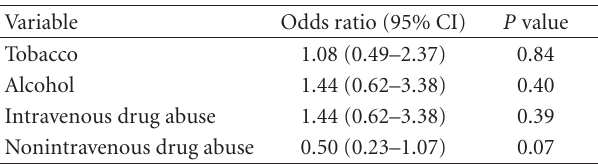
Table 3: Unadjusted associations between social history variables and LTBI in an Ohio correctional facility,